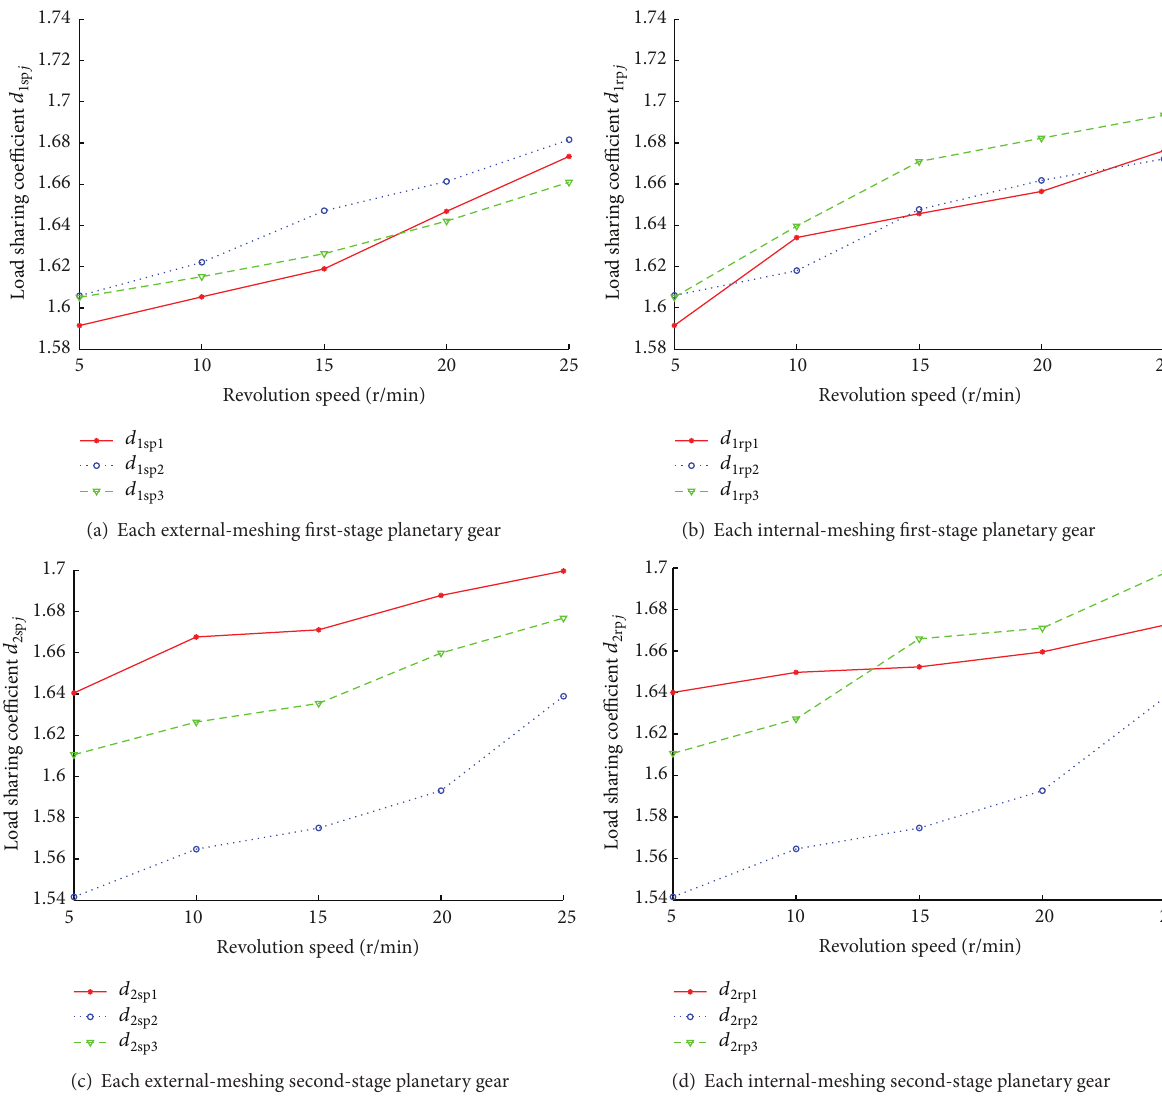
Figure 7: Load sharing coefficient curves of each planetary at different revolution